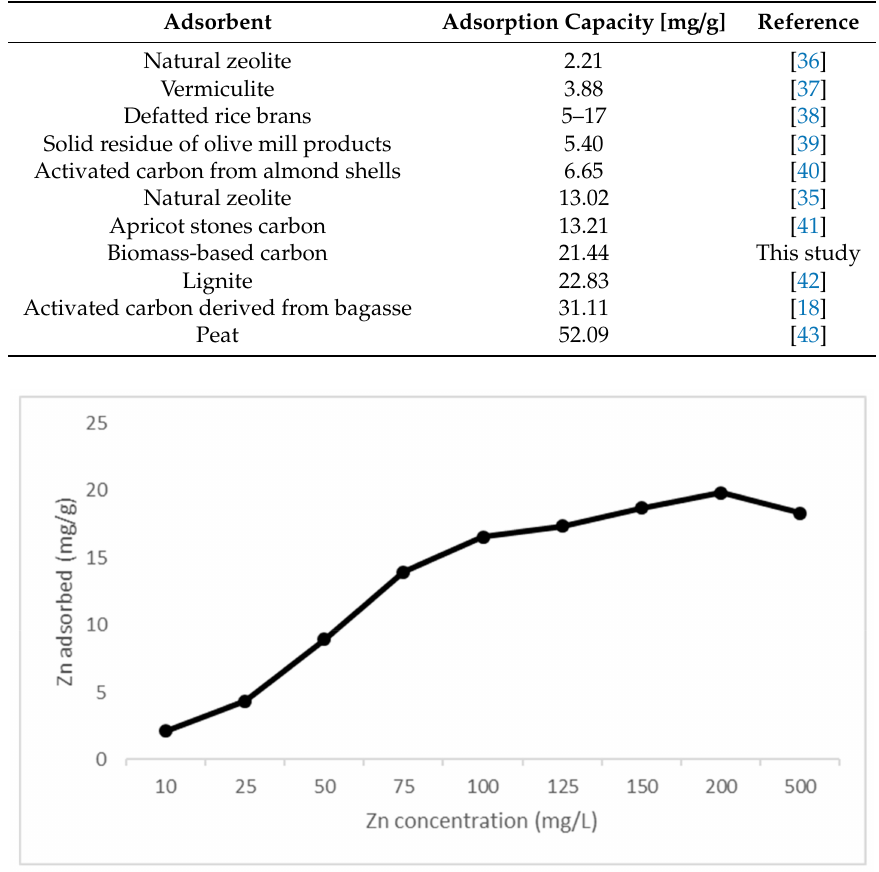
Figure 3. Zinc (Zn) adsorption capacity to carbon surface in di ff erent initial concentrations. Experiments were done duplicated and the range of results were at maximum 0.3 mg /